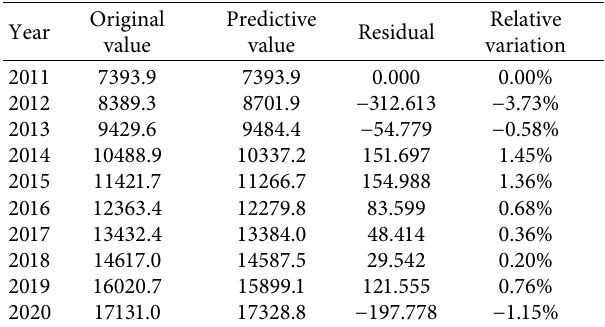
Figure 3: Modeling flowchart of the GM-Markov prediction model. Table 2: Reference table for posterior difference Table 1: Grey system prediction and verification of per capita disposable income of rural residents in China from 2011 to 2020.